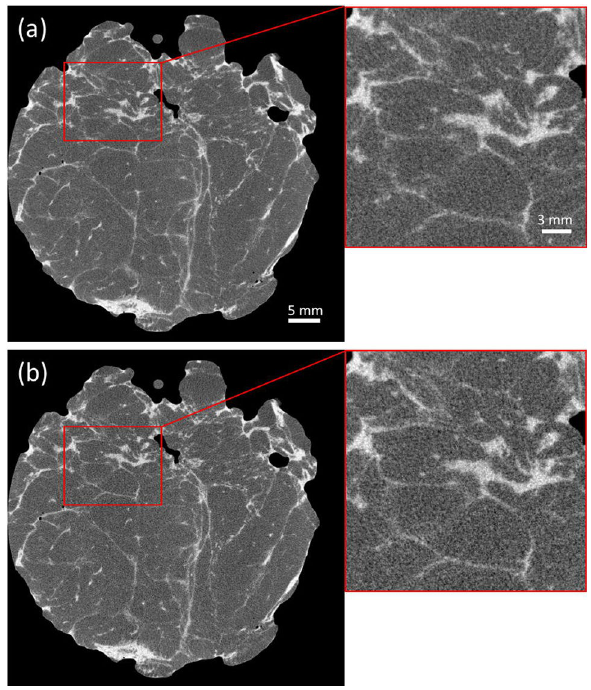
Figure 4. XPCI-CT slices of a 5 cm diameter WLE specimen acquired with an overall scan time of 15 min ( a ) and 10 min ( b ). Zoomed-up regions of interest show images on the same scale as Figs. 1 and